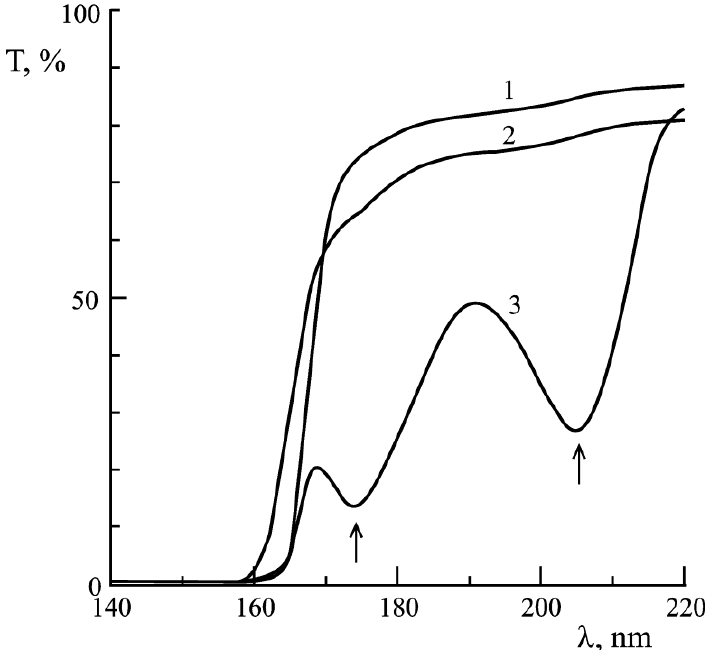
Figure 12. The transmission spectra of Li 290 K: 1—undoped; 2—Cu doped; 3—Ag doped. Adapted from